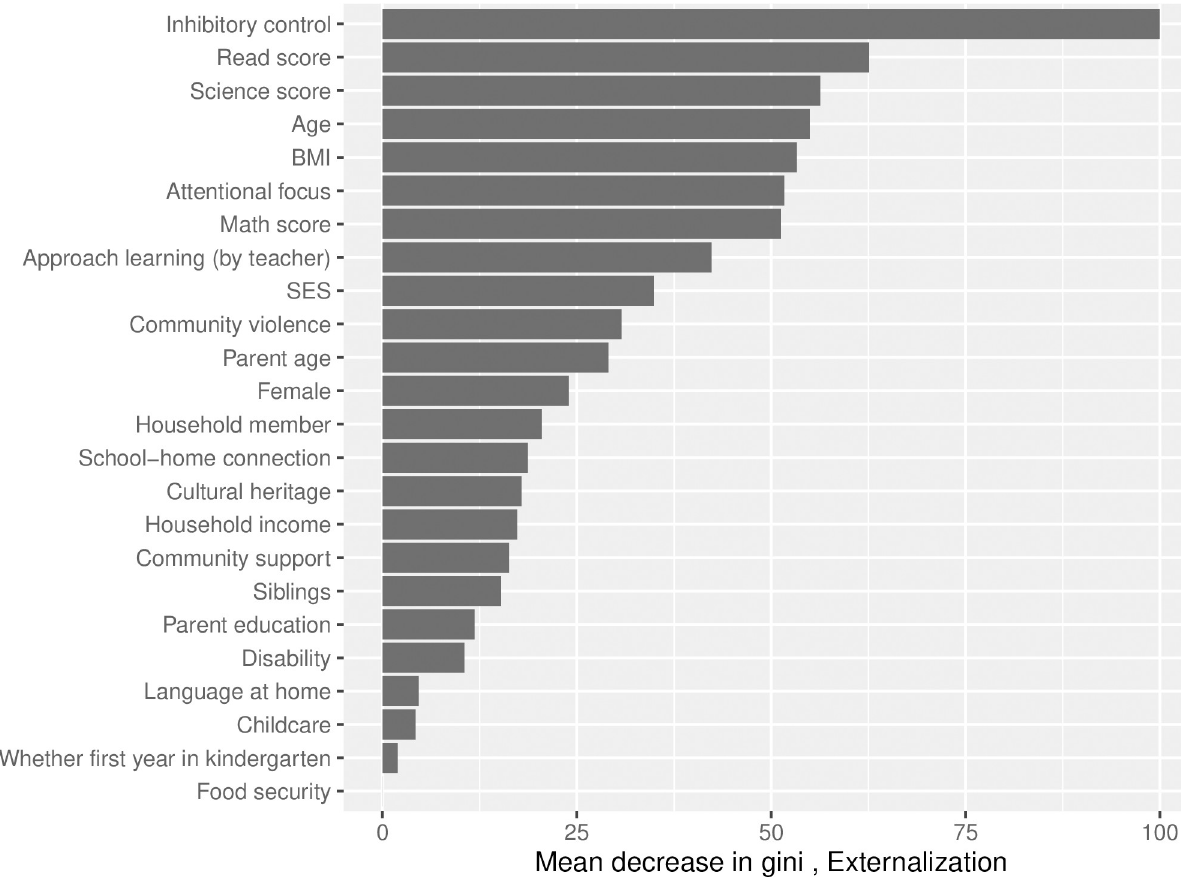
Fig 4. Variable importance metric as measured by mean decrease in gini index (standardized between 0 and 100) for externalizing problem behavior, based on random forest with the number of variables sampled at each split (mtry) = 7 and number of trees (ntree) = 700 fitted on the entire dataset. BMI = body mass index, SES = socioeconomic